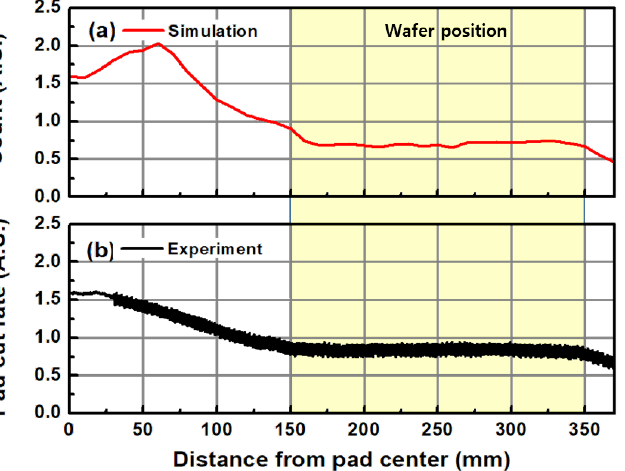
Figure 11. Normalized pad cut rate profile of Case II: ( a ) simulation result and ( b ) experimental result.